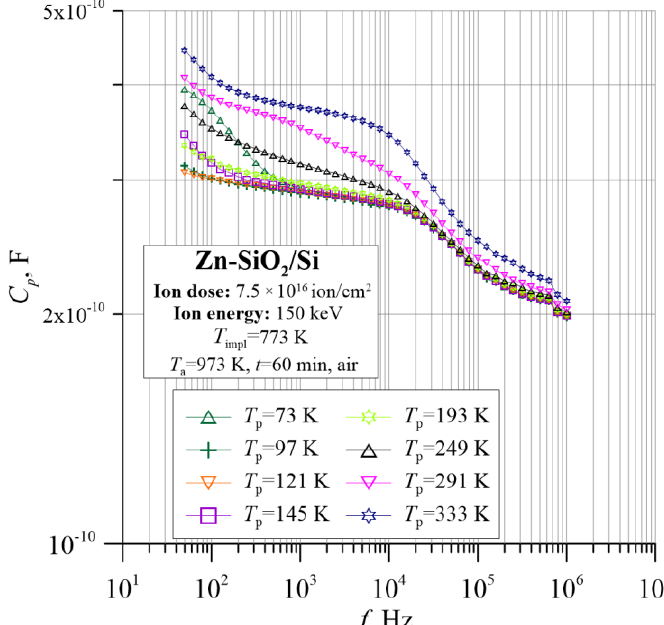
Figure 17. Temperature – frequency dependence of capacity C p ( f , T p ) for the Zn-SiO 2 /Si nanocomposite prepared under “hot” implantation conditions (150 keV, 7.5 × 10 16 ion/cm 2 , T impl = 773 K) after annealing.